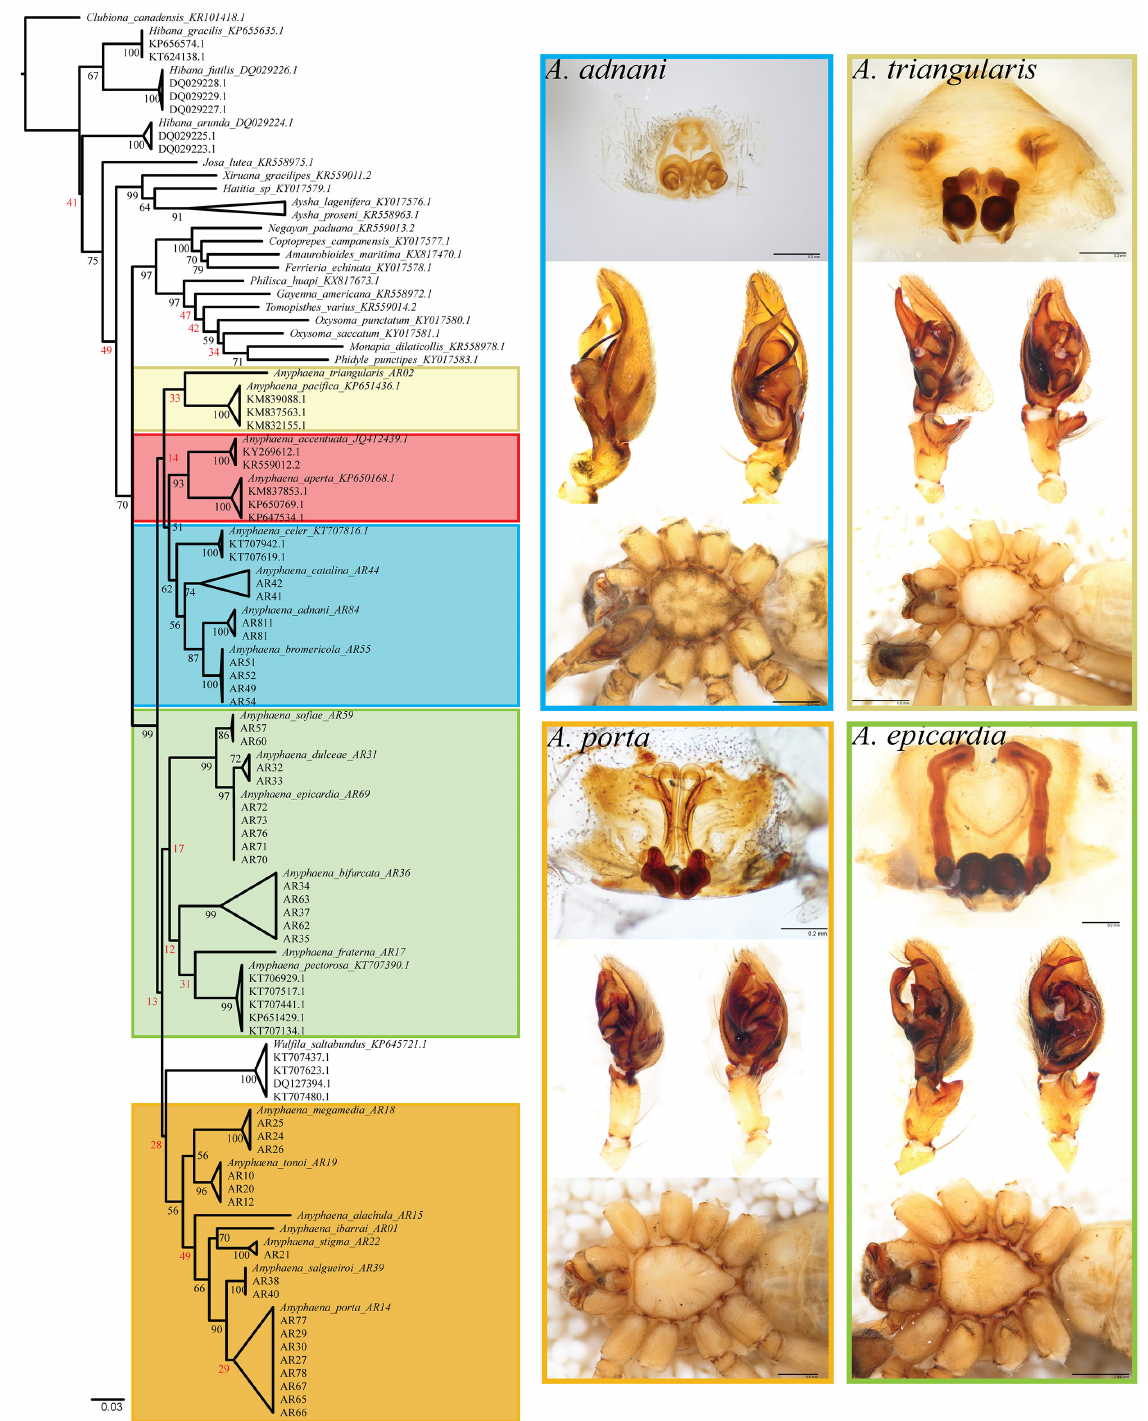
Fig. 53. Tree topology inferred with Maximum Likelihood in RaxML. Colored boxes indicate groups of Anyphaena : pacifica (gold), accentuata (red), celer (blue), pectorosa (green) and porta (ochre). Numbers in the nodes indicate bootstrap support. Support values under 50 are marked in red. Note the position of Wulfila O. Pickard-Cambridge, 1895 as a sister of the porta group